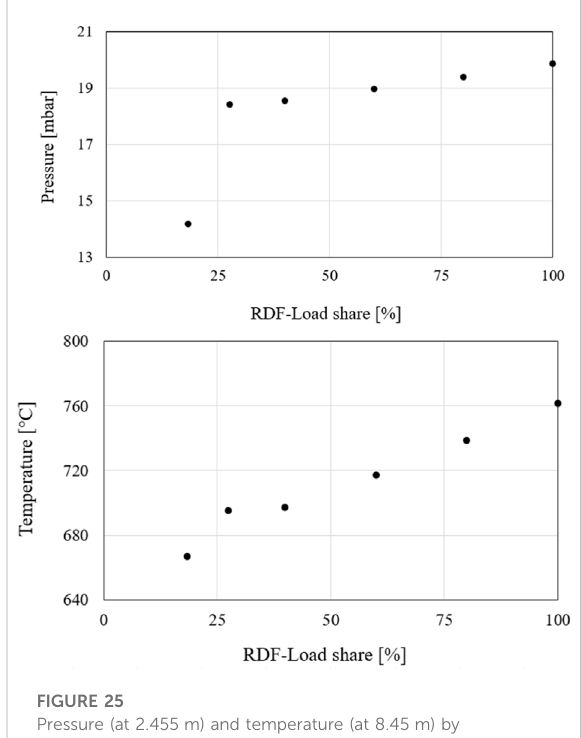
FIGURE 25 Pressure (at 2.455 m) and temperature (at 8.45 m) by variation of the RDF load